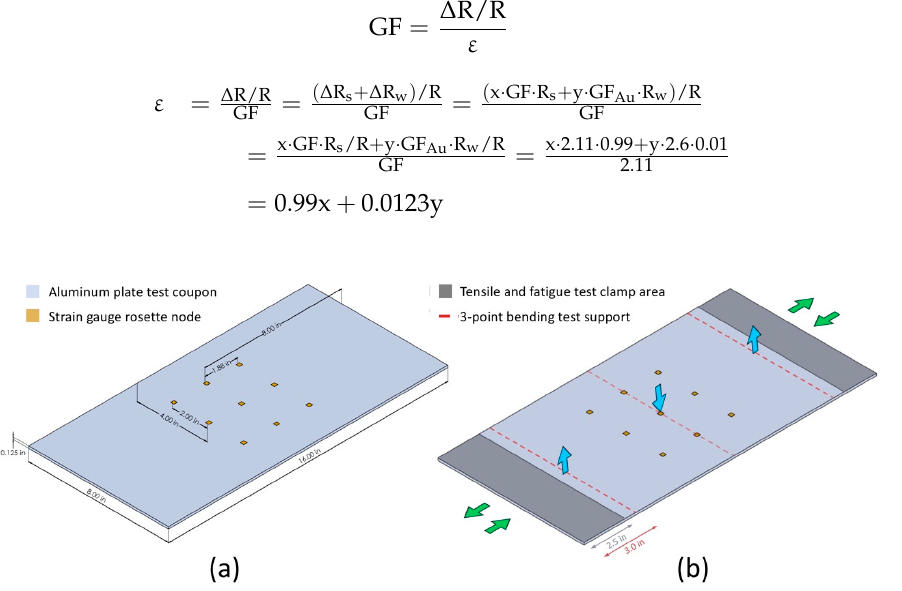
Figure 8. ( a ) Sketches of the test coupon with ( a ) basic dimensions; ( b ) testing dimensions. Sensors 2018 , 18 , x FOR PEER REVIEW